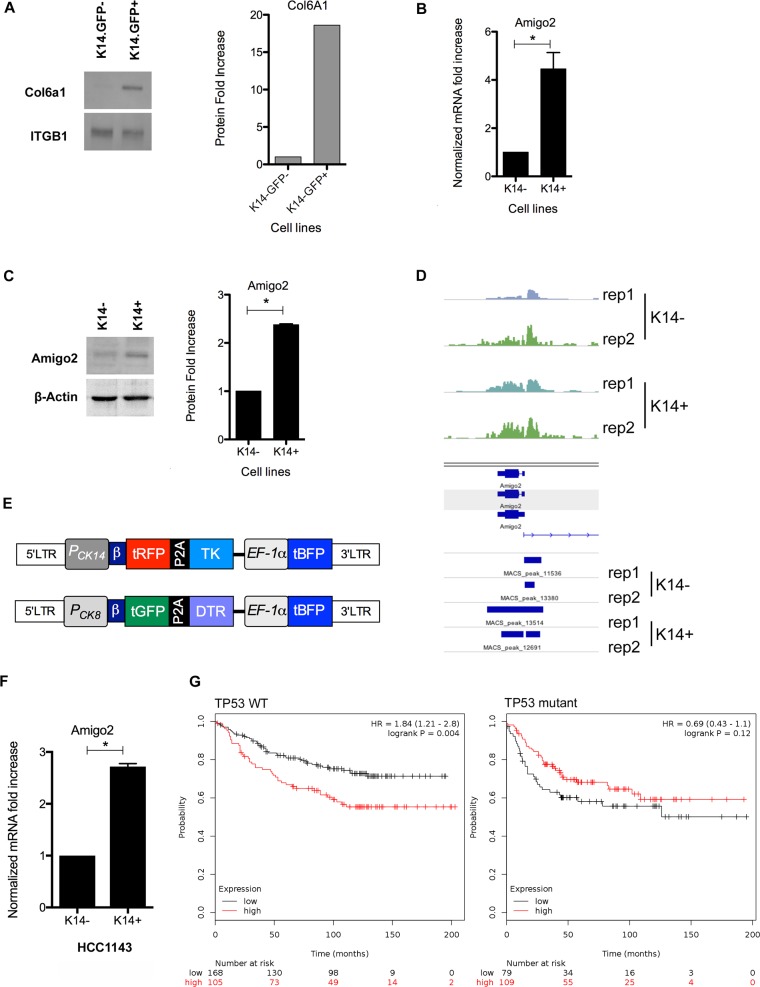
K14+ cells secrete more Col6a1 and express higher levels of Amigo2 than K14− cells.(A) Anti-Col6a1 immunoblots of secreted proteins from K14.GFP+ or K14.GFP− reporter cell lines. CM were concentrated and analyzed for levels of secreted Col6a1. ITGB1, also present in the secretome, was used for loading control. (B) RT-PCR for Amigo2 mRNA level on K14+ and K14− cells. Results show the mean ± SD of 3 independent experiments, p = 0.0126 by paired t test. (C) Amigo2 protein level was detected in K14+ and K14− cell lysates by western blot. Quantification of 3 independent experiments, p < 0.0001 by paired t test; mean ± SD is shown. (D) Chip for H3K27Ac shows the magnitude of the peaks for K14+ and K14− replicates at the Amigo2 locus. (E) Cartoon of self-inactivating lentiviral K14.tRPT (upper cartoon) and K8.tGPD reporters (lower cartoon). (F) RT-PCR analysis of Amigo2 mRNA expression in K14+ or K14− human breast cancer cell line HCC1143. Quantification of independent experiments in triplicates p = 0.0148 by paired t test; mean ± SD is shown. (G) Kaplan-Meier plot in TP53 mutant and TP53 WT breast cancer show relationship between Amigo2 expression and relapse-free survival. Amigo2, amphoterin-induced protein 2; Chip, chromatin immunoprecipitation; CM, conditioned medium; Col6a1, Collagen VI subunit A; DTR, diphtheria toxin receptor; EF-1α, elongation factor 1α; GFP, green fluorescent protein; H3K27Ac, histone 3 lysine 27; ITGB1, integrin β-1; K, cytokeratin; K8.tGPD, keratin-8 promoter followed by turbo green fluorescent protein and diphtheria toxin receptor; K14.tRPT, keratin-14 promoter followed by a turbo red fluorescent protein and herpes simplex virus thymidine kinase; LTR, long terminal repeat; RT-PCR, real-time PCR; tBFP, turbo blue fluorescent protein; tGFP, turbo green fluorescent protein; TK, thymidine kinase; tRFP, turbo red fluorescent protein; WT, wild-type.